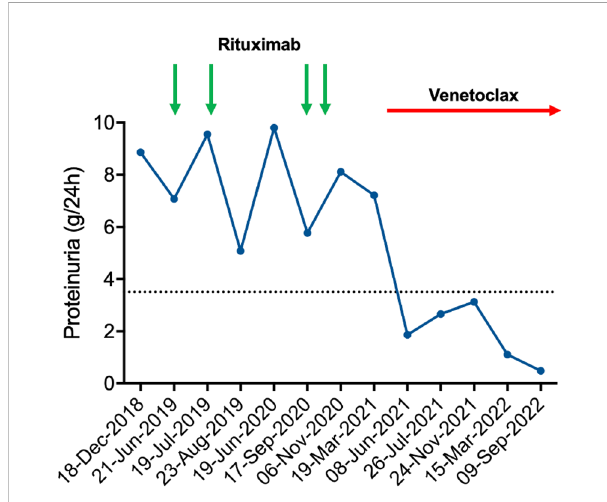
FIGURE 2 Proteinuria time course. Schema of patient ’ s proteinuria in relation to treatments administered. Rituximab was administered at 700 mg each dose. Venetoclax was started according to the standard ramp- up schedule. As evident by the graph, proteinuria had a partially remitting-relapsing course during rituximab treatment, with all values persistently above the nephrotic threshold (dashed line). By contrast, venetoclax led to a rapid and durable reduction of proteinuria that fell below the nephrotic threshold.